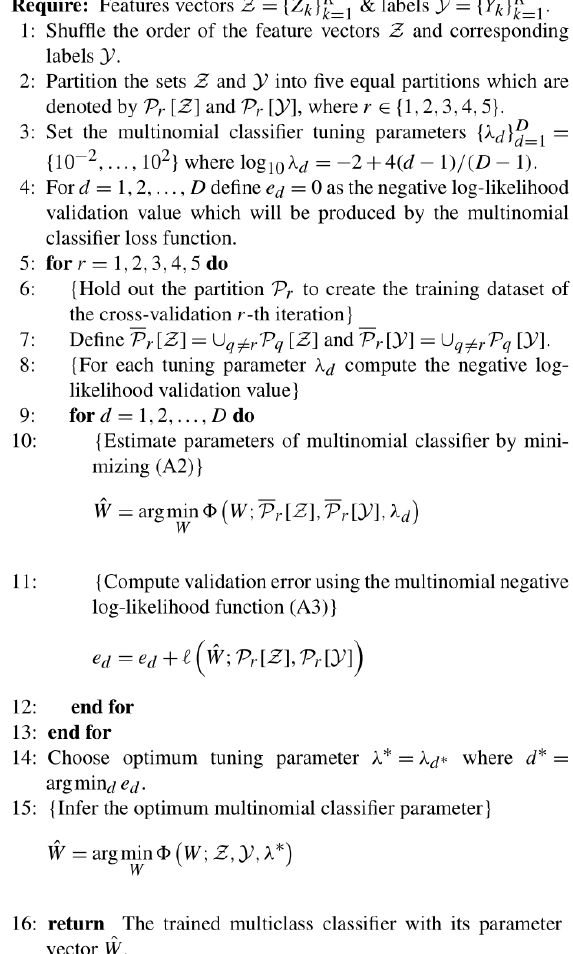
Algorithm 1 employs Algorithm 1a to estimate the op- timum weight matrix W . In more detail, with the training Algorithm 1a estimates the weight matrix W by